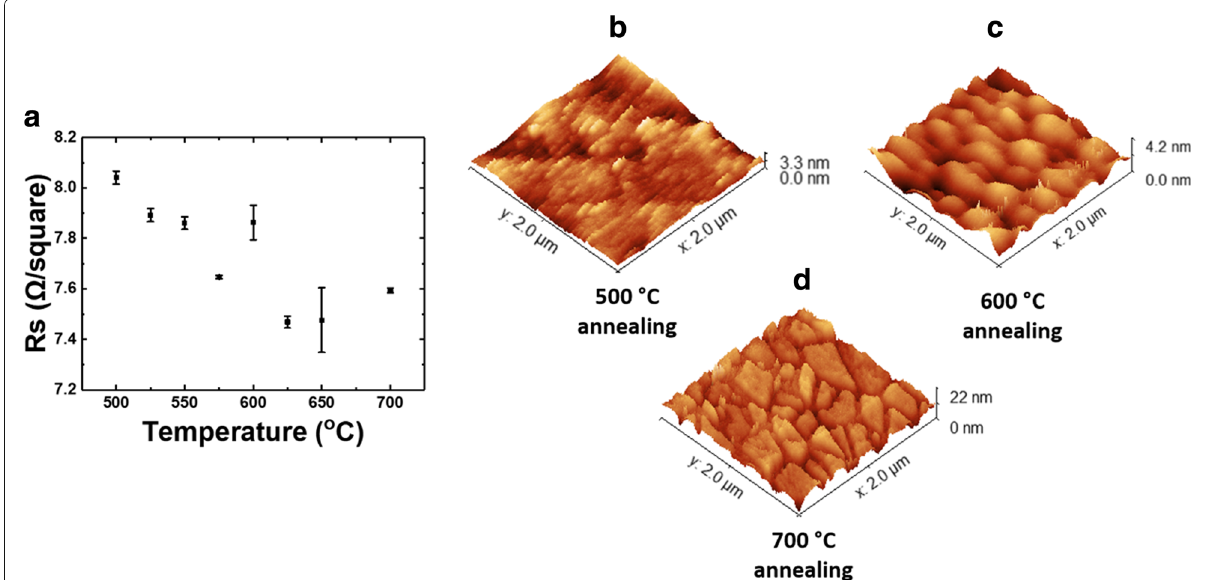
Fig. 1 Effect of annealing temperature on the electrical and physical characteristics of deposited ITO thin film. a Sheet resistance measured with a four-point probe after annealing at different temperatures. AFM surface topography of the ITO thin film acquired after annealing the sample at b 500 °C, c 600 °C, and d 700